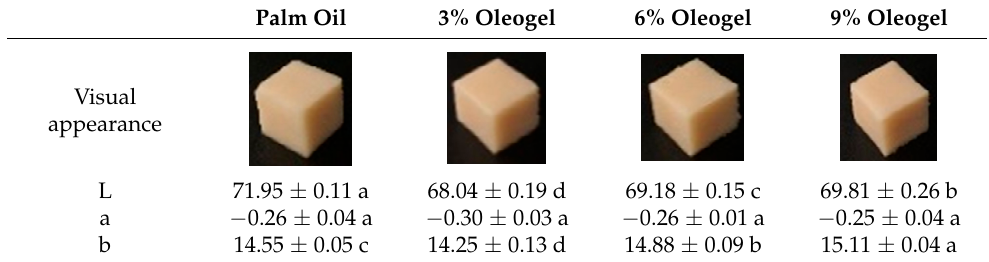
Table 1. Visual appearance and color of the imitation cheeses prepared with palm oil and oleogels.